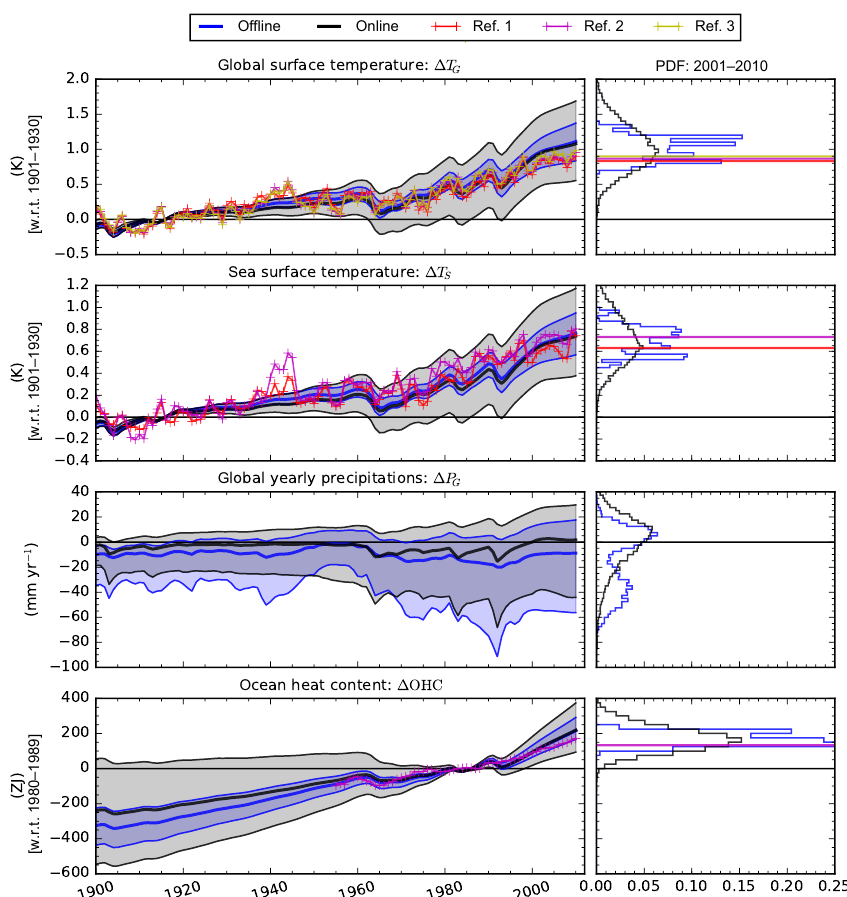
Figure 12. Results of our simulations with OSCAR, for climate, with the same format as for carbon dioxide. Reference 1 is Had- CRUT4 (Morice et al., 2012) for global surface temperature, and HadISST1 (Rayner et al., 2003) for sea surface temperature. Refer- ence 2 is NOAA/NCDC (Smith et al., 2008) for global surface temperature, ERSST4 (Huang et al., 2015) for sea surface temperature, and NOAA/NODC (Levitus et al., 2012) for ocean heat content. Reference 3 is GISTEMP (Hansen et al., 2010) for global surface